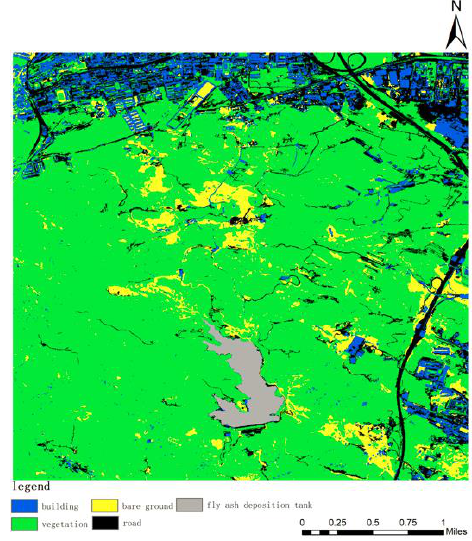
Figure 4. Results of image classification in 2010.